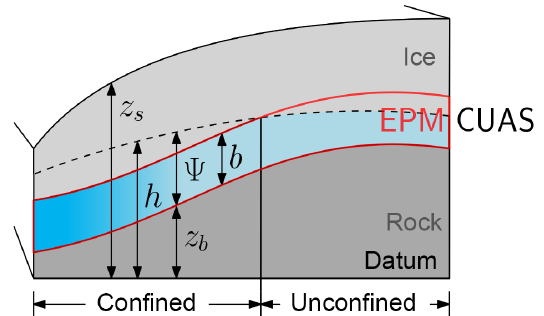
Figure 1. Sketch of the EPM model and artificial geometry for ex- periments. The left side is towards the glacier snout. The red border shows the location of the equivalent porous medium that is mod- eled. The blue gradient indicates the locally increased transmissiv- ity. When (cid:57) < b , the system becomes